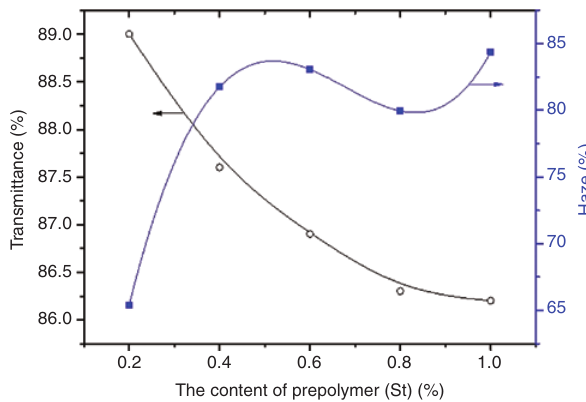
Figure 4: The effect of the prepolymer (St) concentration on the optical performance of the